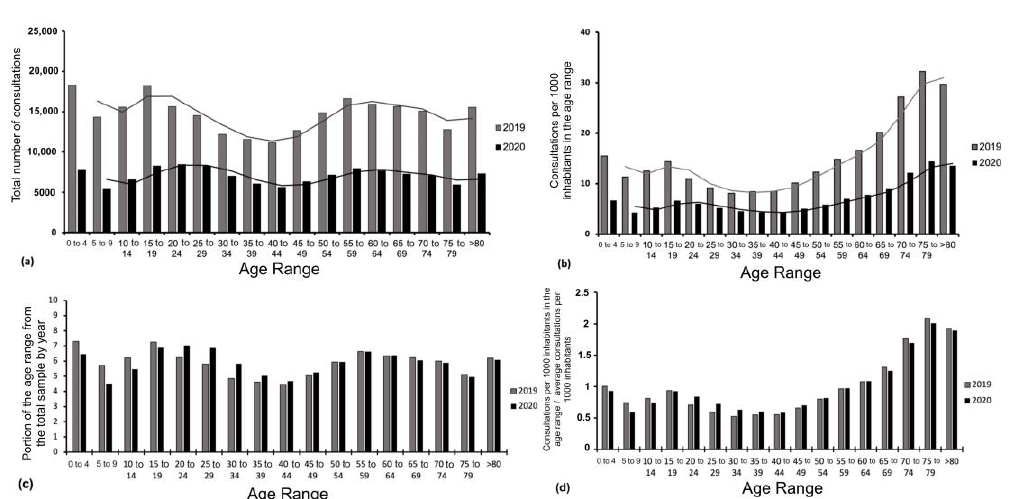
Figure 3. Dermatology consultations by age range according to total consultations and ( a ) according to the number of consultations per 1000 inhabitants in the age range; ( b ) their respective average trend lines, for the years 2019 and 2020; ( c ) dermatology consultations by age range with respect to the total consultations for the year; and ( d ) the ratio between the incidence of dermatology consultations per 1000 inhabitants of a specific age range and the average incidence of dermatology consultations per 1000 inhabitants.